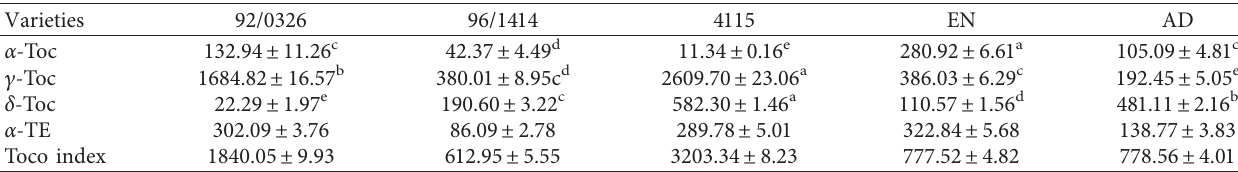
Table 4: Tocopherol isomers content of edible cassava leaf variety harvested in rainy season at 15 months after planting (15MAP, 15–25 ° C, and 950–1100mm).